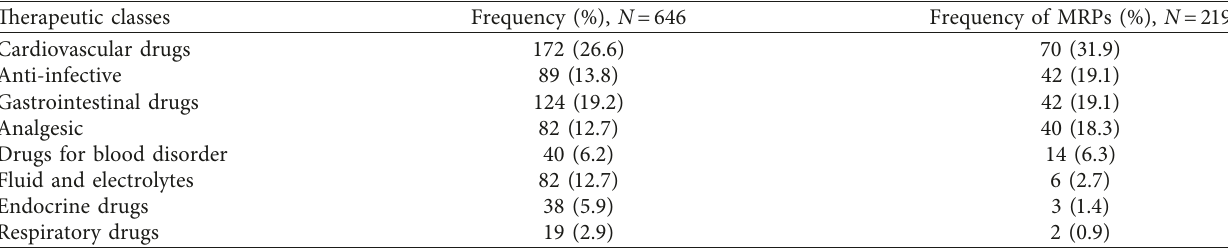
Table 4: Classes of medications commonly prescribed and related with MRPs among study participants at JUMC, Jimma Zone, Jimma, Southwest Ethiopia, from April 1 to September 30, 2018.